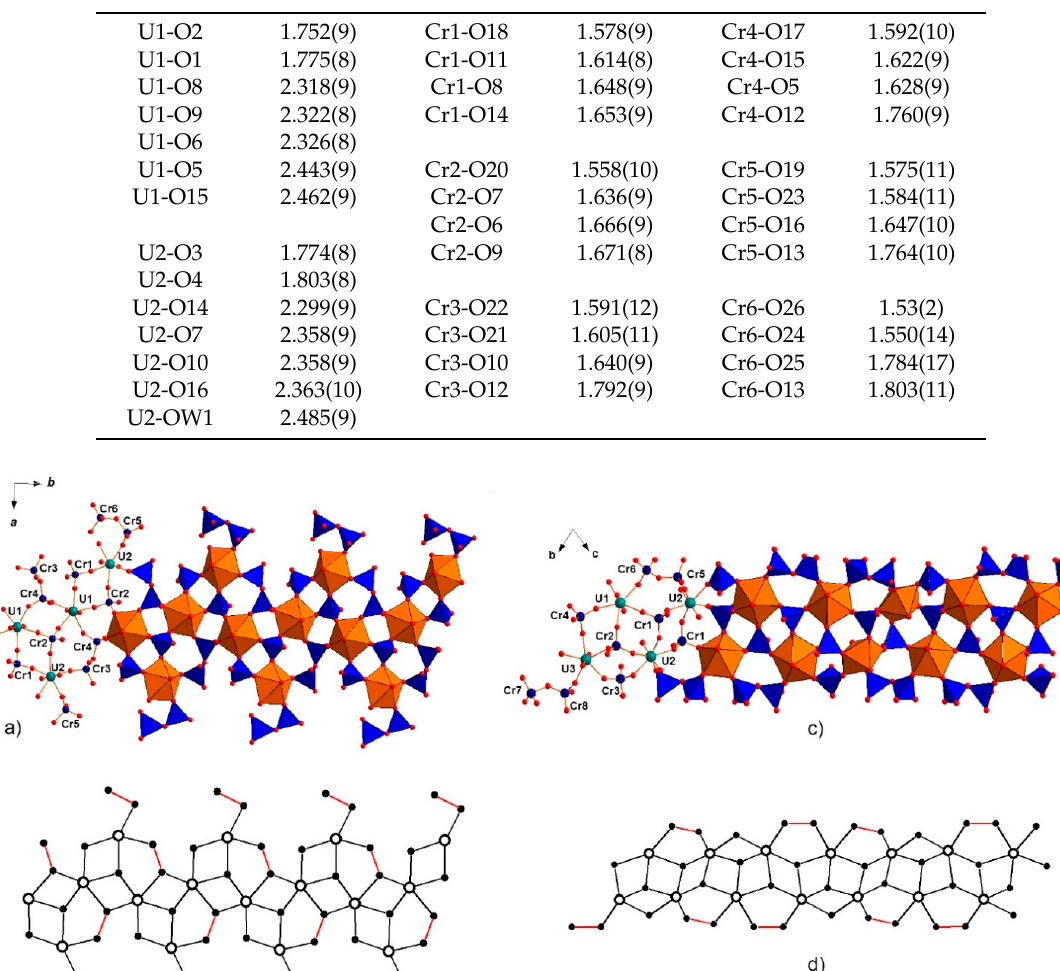
Table 3. Selected interatomic distances (Å) in 2 .